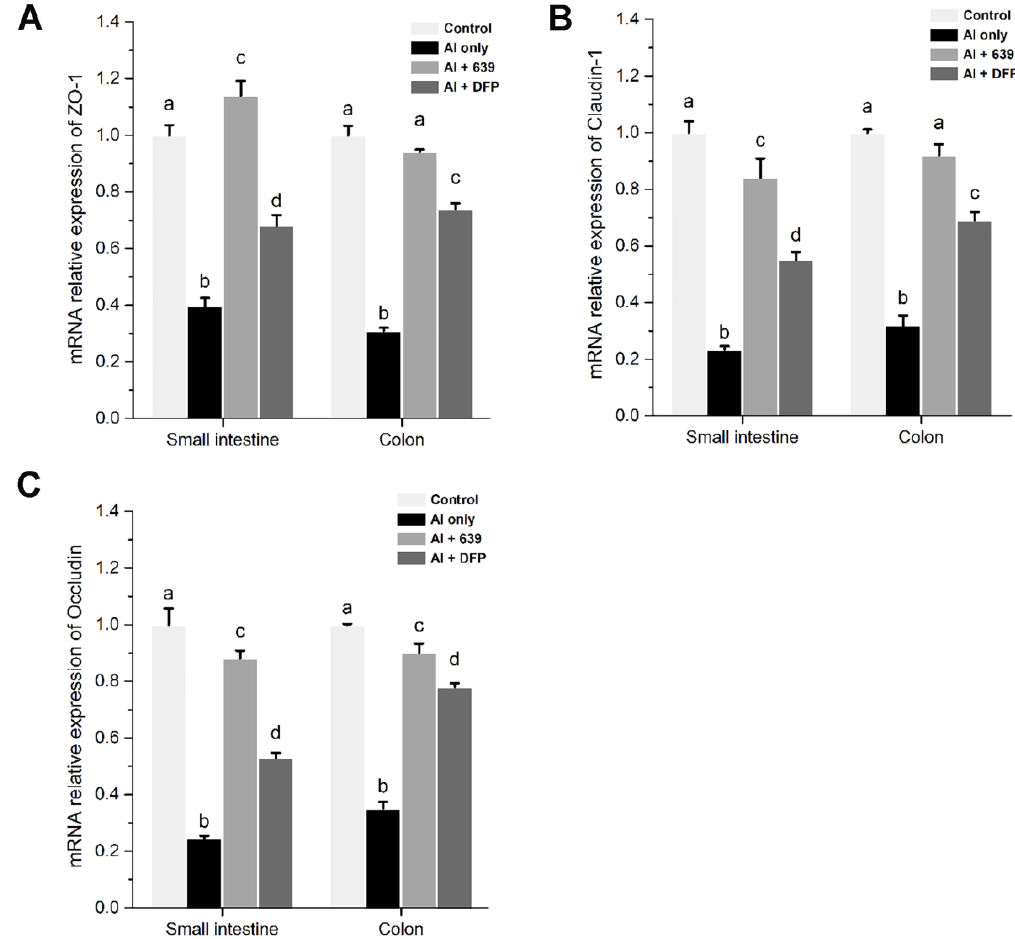
Figure 4. Effects of L. plantarum CCFM639 on Al ‐ induced alterations of mRNA expression levels of tight junction proteins in intestine: ( A ) the mRNA expression levels of ZO ‐ 1; ( B ) the mRNA expression levels of claudin ‐ 1; and ( C ) the mRNA expression levels of occludin. Values are expressed as fold change versus control group and presented as the mean ± SEM. The different letters a–d indicate statistically significant changes among the four groups ( p < 0.05).